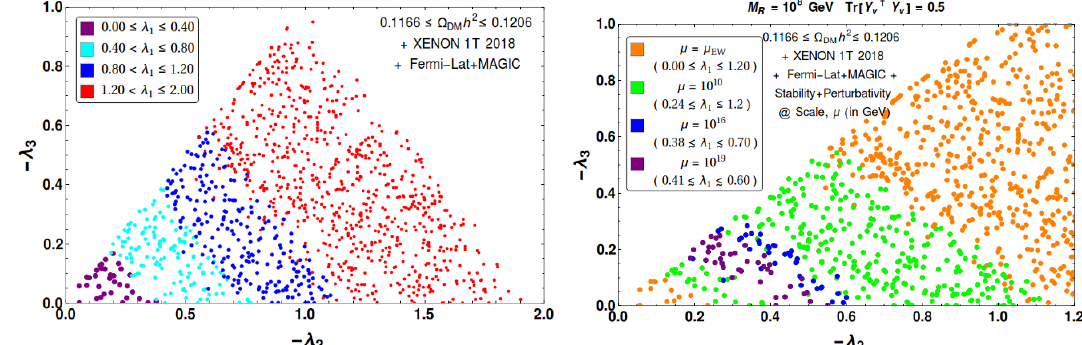
Figure 25 . Relic density, direct search and indirect search allowed points in 2 (cid:21) 2 versus (cid:21) 1 plane (left (cid:12)gure) and m points). We also (cid:12)nd high scale validity of the model following eqs. (3.1), (3.4) and (3.5) by considering the high scale to be 10 10 GeV (green), 10 16 GeV (blue) and 10 19 GeV (red). Right handed neutrino mass and Yukawa couplings are kept (cid:12)xed at M R = 10 8 GeV, Tr[ Y y m t = 173 : 1 GeV.